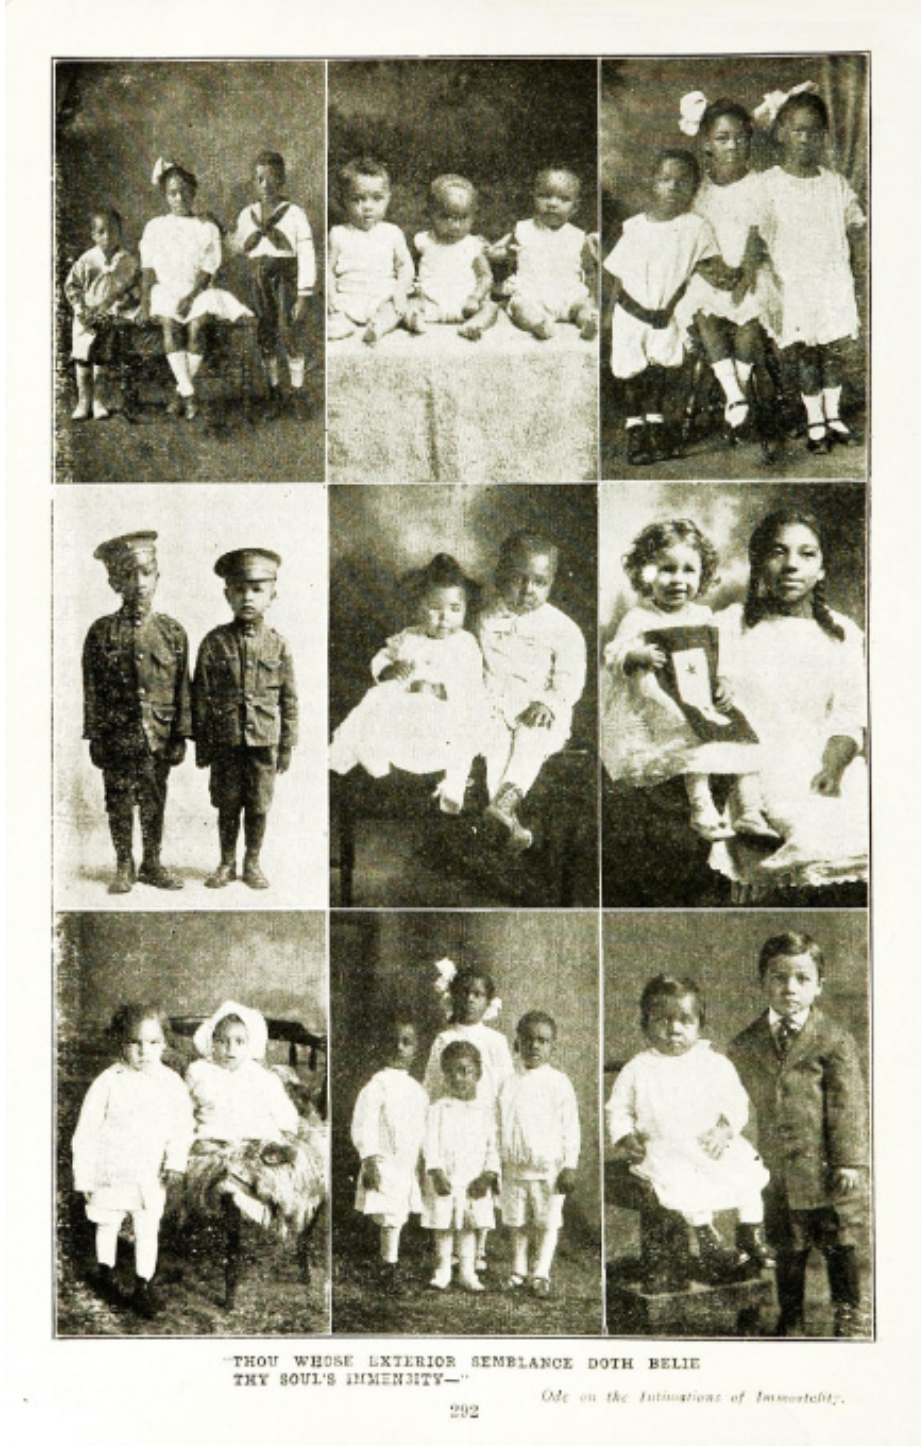
Figure 5. A page from the 1919 Children’s Number demonstrating the sharp contrast of light and dark tones that characterizes many photos in these issues. ( The Crisis 1919, 18.6, p. 292), The Modernist Journals Project, https://modjourn.org/issue/bdr512545/, (accessed on 17 January 2022). According to Bernstein (2011), following the Civil War, “pain functioned as a wedge that split childhood innocence, as a cultural formation, into distinct black and white trajectories. White children became constructed as tender angels while black children were libeled as unfeeling, noninnocent nonchildren” (p. 33). Pain, therefore, becomes a kind of